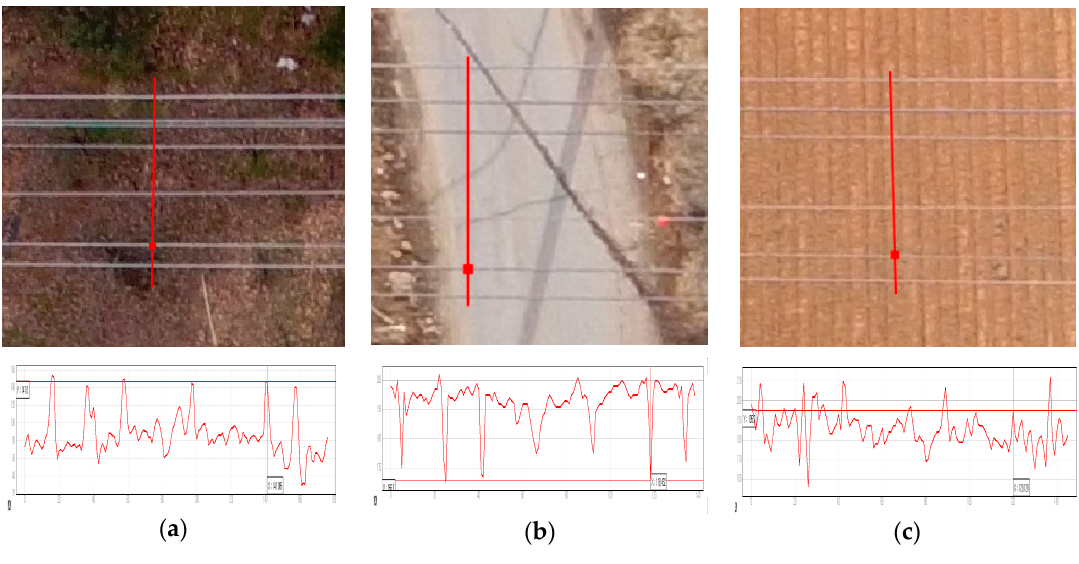
Figure 8. Power line image samples for different backgrounds.